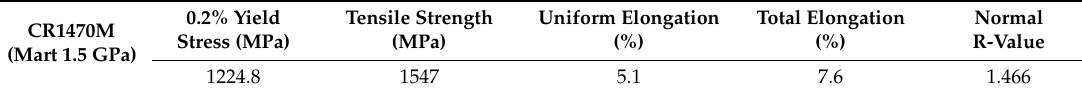
Figure 1. Concept of local heat-assistant cold forming.